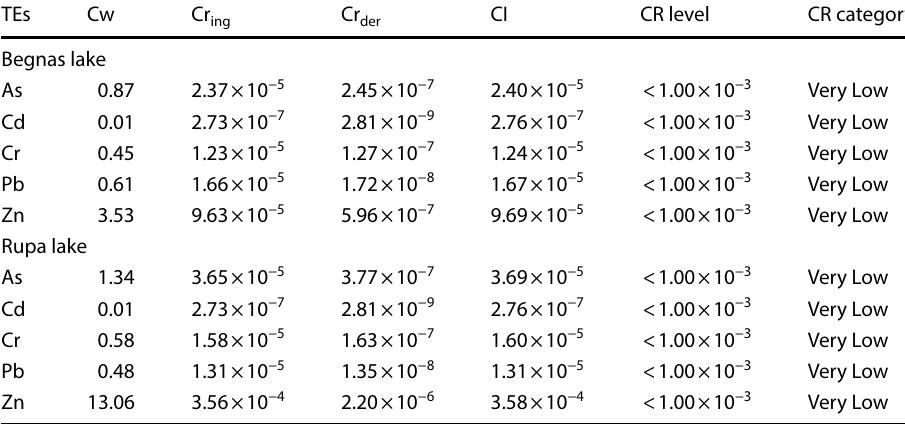
Table 7 Cancer risk assessment of the trace elements (TEs) of Begnas Lake and Rupa Lake, Gandaki Province,